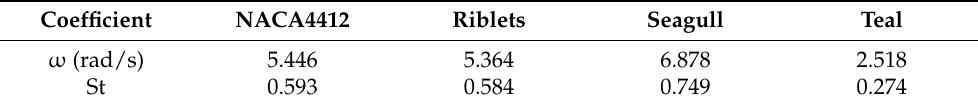
Figure 5. The lift coefficients C L of NACA4412, Riblets, Seagull, and Teal airfoil. Table 3. Vortex shedding angular frequency and St number.